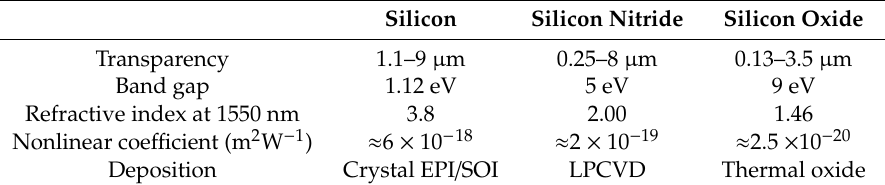
Table 1. Comparison of silicon, silicon nitride and silicon oxide, information extracted from LIGENTEC [39].